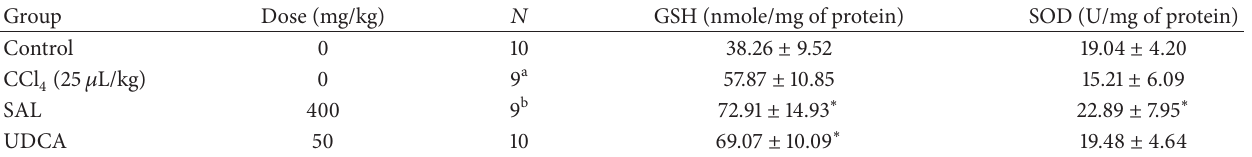
Table 5: Effect of composition SAL on oxidative stress biomarkers in liver homogenates collected from CCl 4 induced hepatotoxicity model.